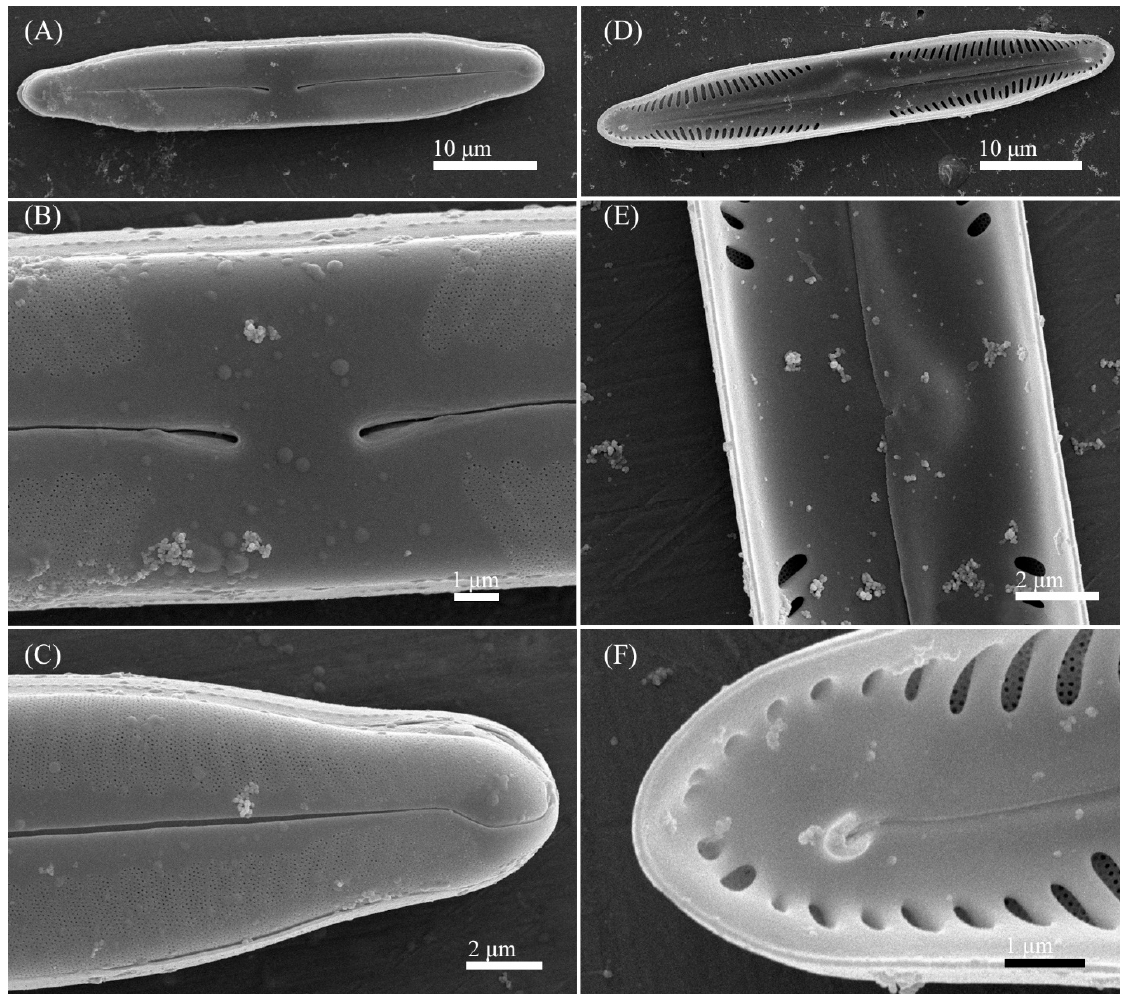
Figure 10. Pinnularia insolita Kezlya, Maltsev, Krivova et Kulikovskiy sp. nov. Strain VP280 sample No. 07038. Scanning electron microscopy. ( A – C ) External views. ( D – F ) Internal views. ( A , D )